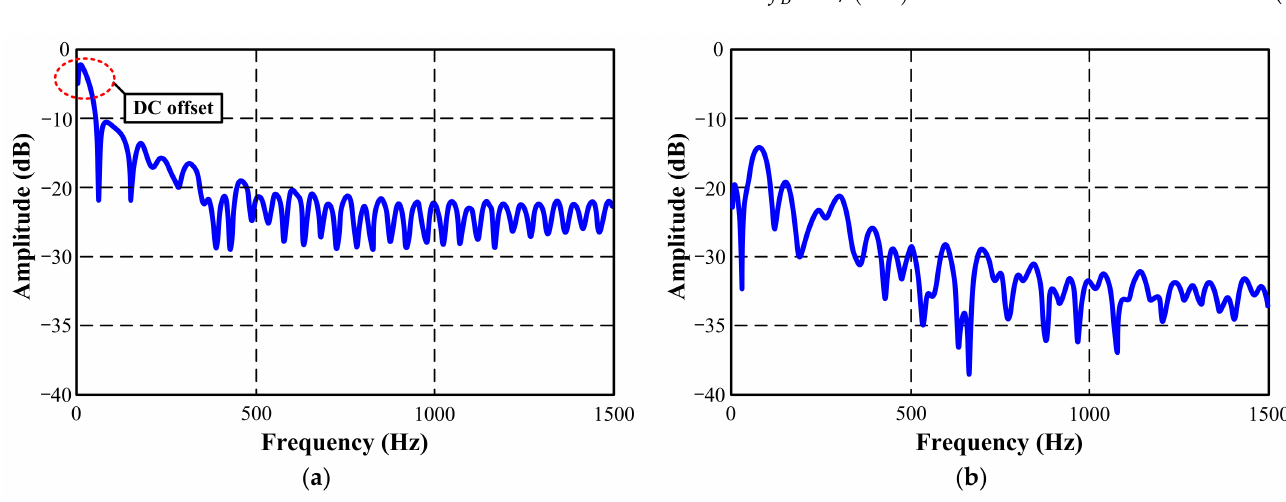
Figure 7. Amplitude of received signal in frequency domain ( a ) with and ( b ) without DC